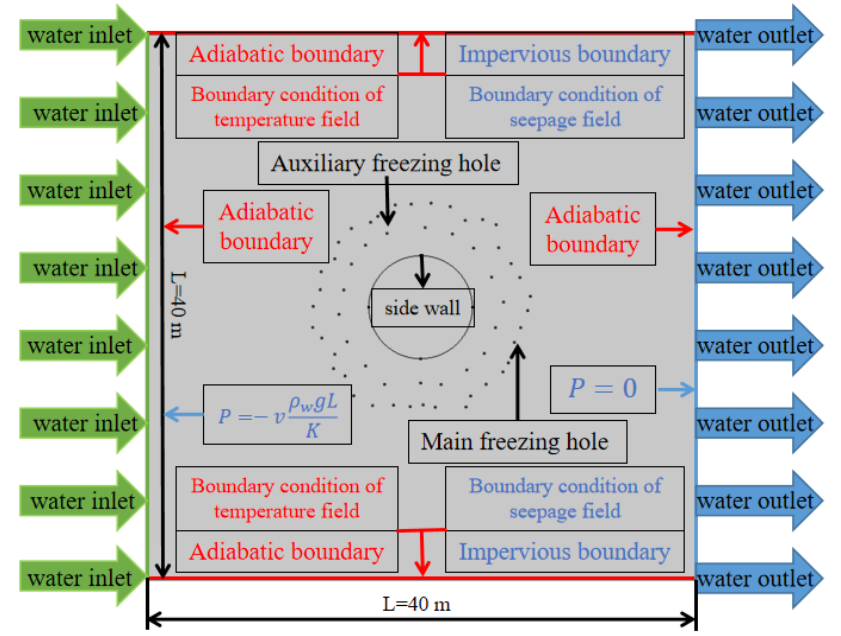
Figure 4. The numerical calculation model.